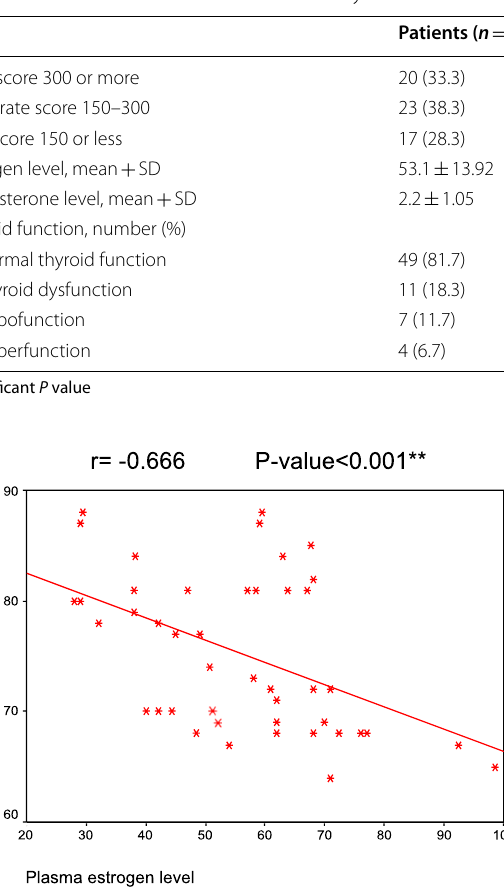
Table 4 Assessment of stressful life events by Holmes and Rahe Stress Scale and hormonal essay among studied groups